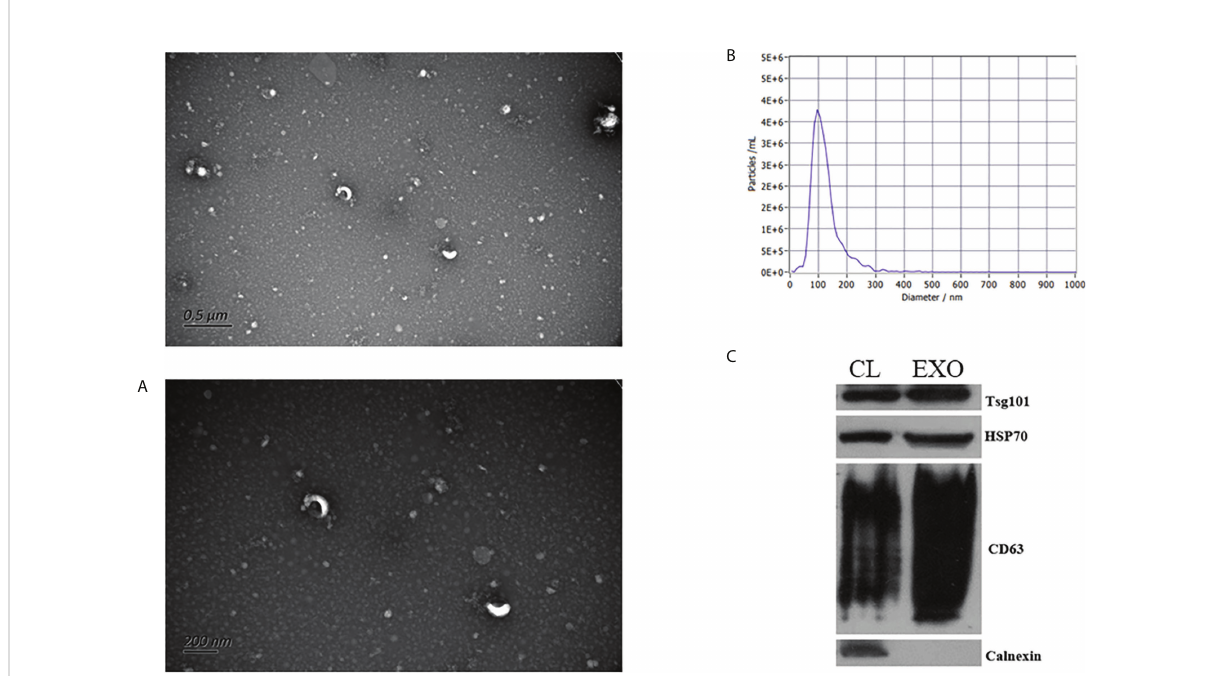
FIGURE 1 Identi fi cation of exosomes. Transmission electron microscopy images of exosomes (A) . Nanoparticle tracking analysis results (B) . Western blot analysis of exosome marker proteins (C)